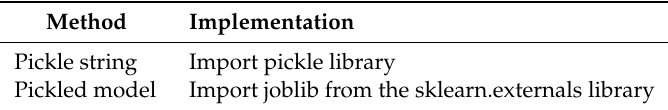
Table 10. Machine learning model store